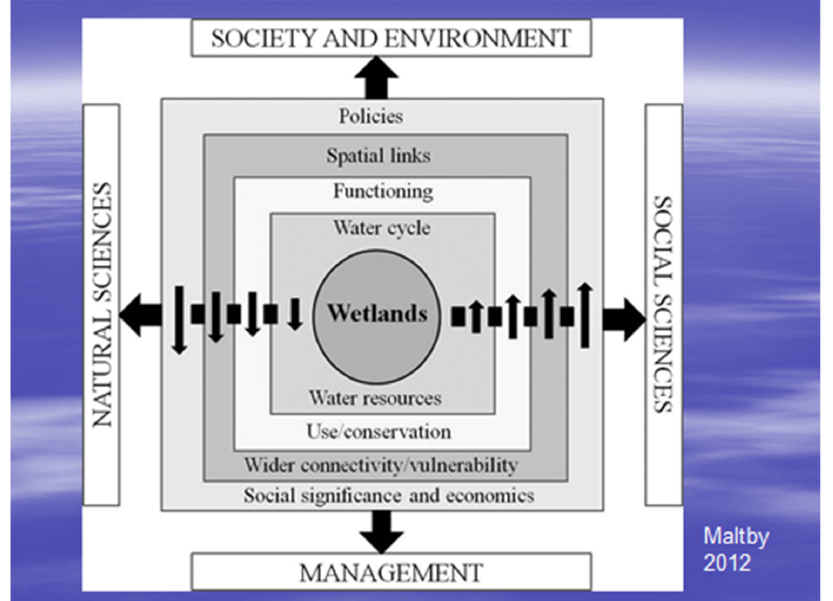
Figure 27. Outline of the new wetland paradigm with multiple linkages among the natural world and human society